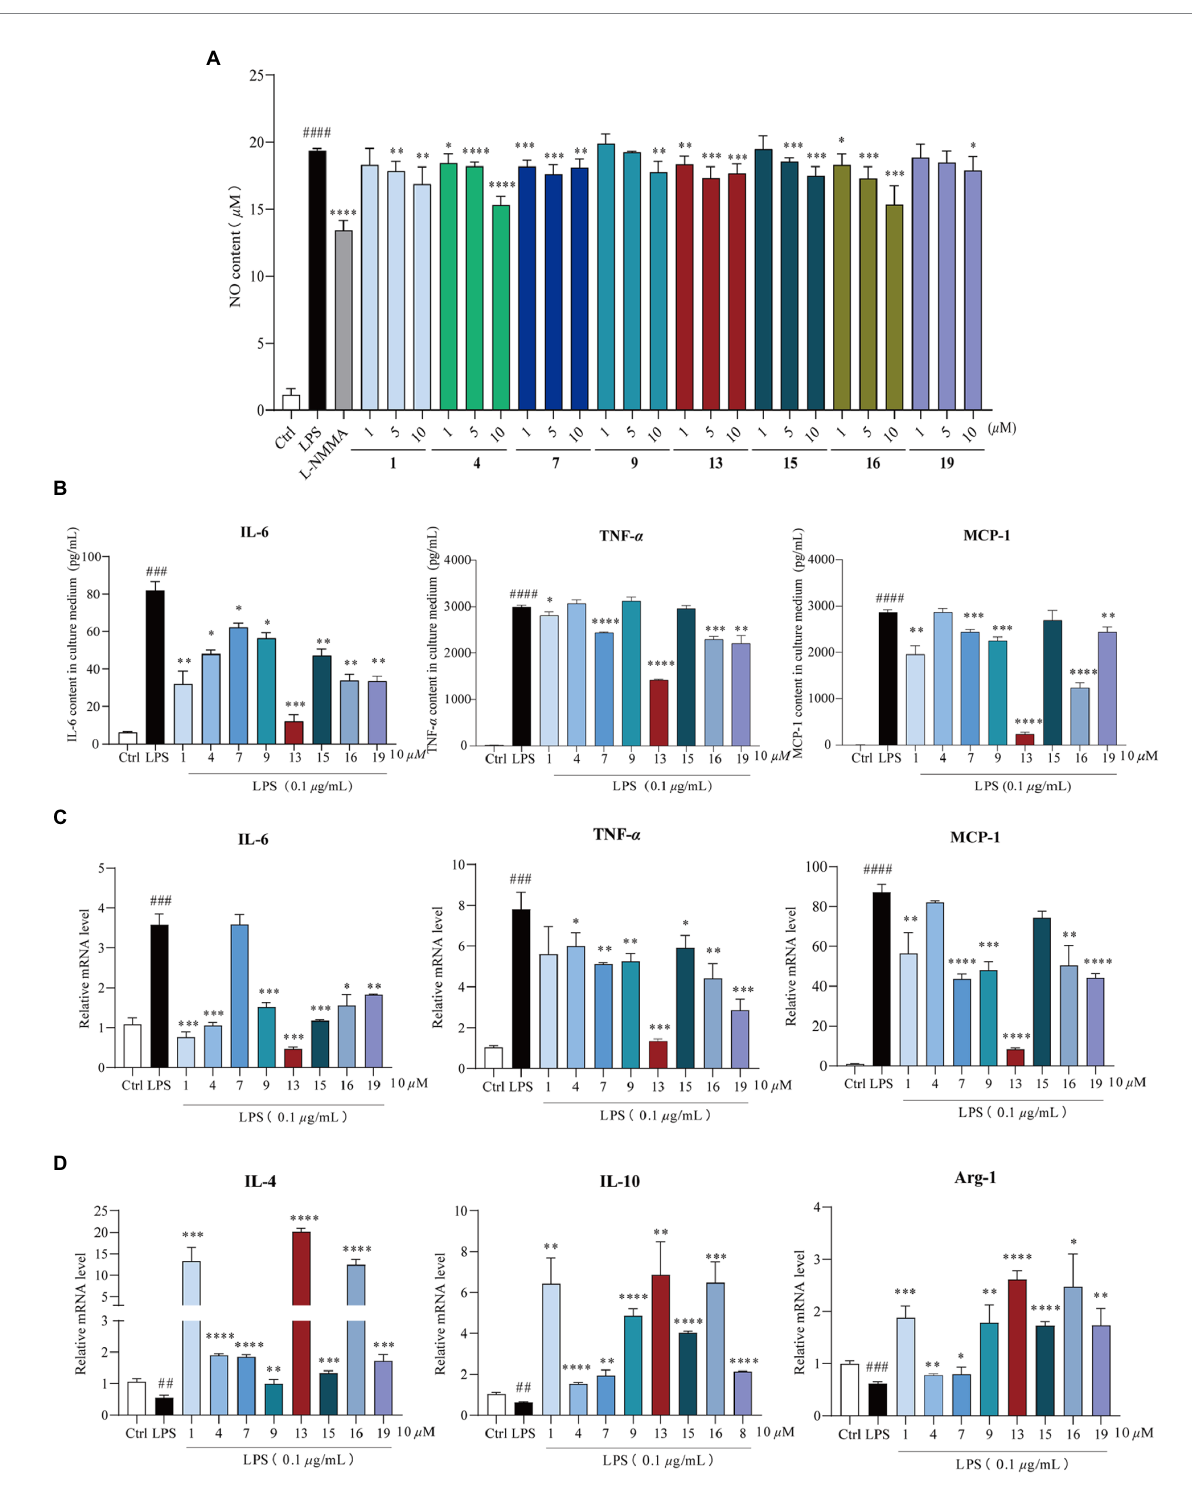
FIGURE 4 Anti-inflammation activity of compounds 1 , 4 , 7 , 9 , 13 , 15 , 16 , and 19 . Cells were exposed to 0.1 μ g/ml lipopolysaccharide (LPS) and co-treated with 1 , 4 , 7 , 9 , 13 , 15 , 16 , and 19 (1, 5, and 10 μ M) for 24 h, respectively. (A) Nitric oxide (NO) production in the supernatant after 24 h of LPS induction, n = 5. L-NMMA was used as the positive control; (B) compounds 1 , 4 , 7 , 9 , 13 , 15 , 16 , and 19 reduced LPS-induced IL-6, TNF- α , and MCP-1 release, n = 3; (C) qPCR analysis of M1-type macrophage genes (IL-6, TNF- α , and MCP-1) normalized by β -actin, n = 3; (D) qPCR analysis of M2-type macrophage genes (IL-4, IL-10, and Arg-1) normalized by β -actin, n = 3. All data were presented as the mean ± SD of three independent experiments. ns, p > 0.05, * p < 0.05, ** p < 0.01, *** p < 0.005, **** p < 0.001 vs. LPS group; ## p < 0.01, ### p < 0.005, #### p < 0.001 vs. control group, n = 3. p value was assessed by two-tailed Student’s t